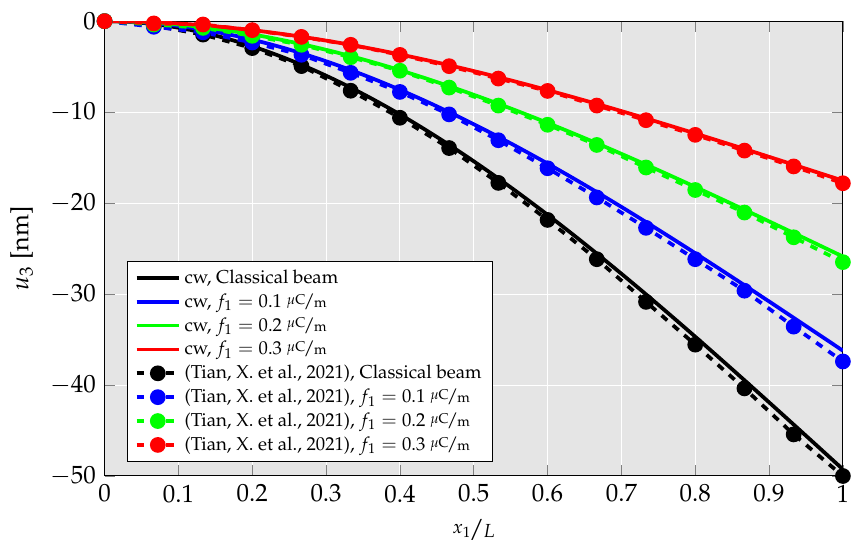
Figure 6. Comparison of deflection of the cantilever beam between the results in the literature and of the current work using linear element for different flexoelectric coefficients f 1 . “cw” denotes the current work.